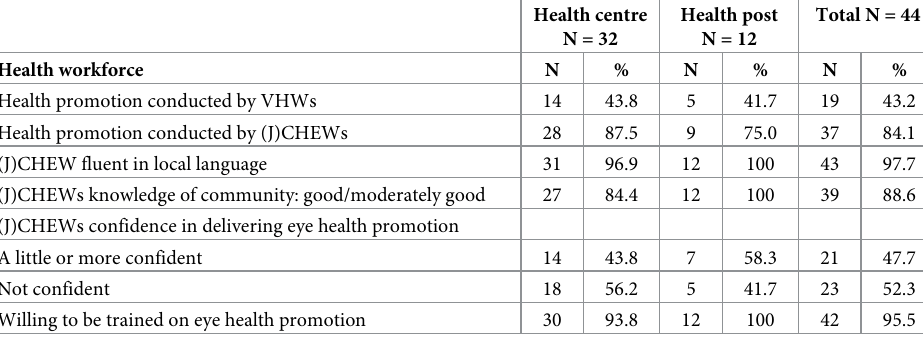
Table 2. Health workforce for community health